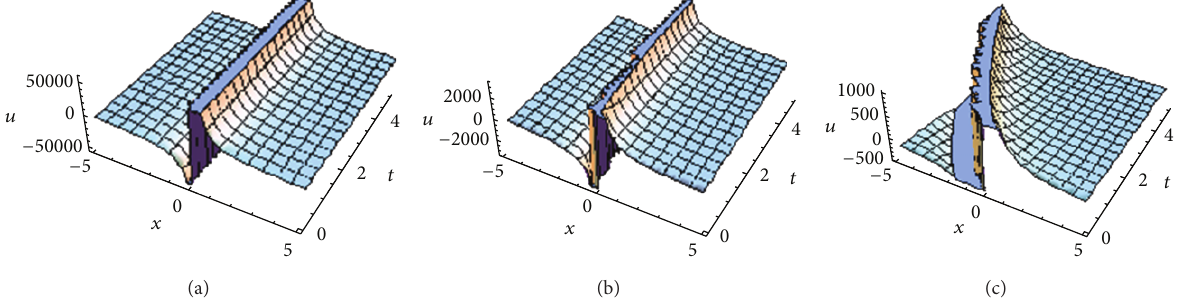
Figure 2: Graphics of the solution equation (40) corresponding to the values 𝛼 = 𝛽 = 0.01 , 𝛼 = 𝛽 = 0.25 , and 𝛼 = 𝛽 = 0.75 from left to right when 𝑘 = 𝑎 1 = 𝑏 0 = 𝑏 1 = 𝛾 = 0.01 , −5 < 𝑥 < 5 , and 0 < 𝑡 < 5 .